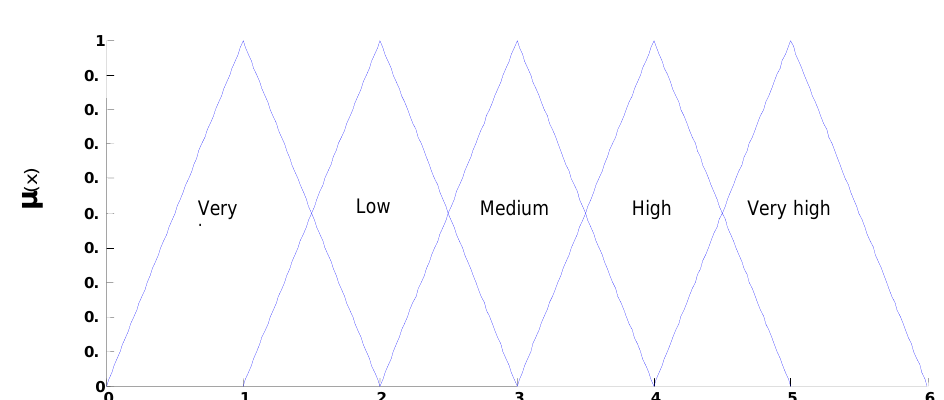
Figure 3: Generating possible scenarios